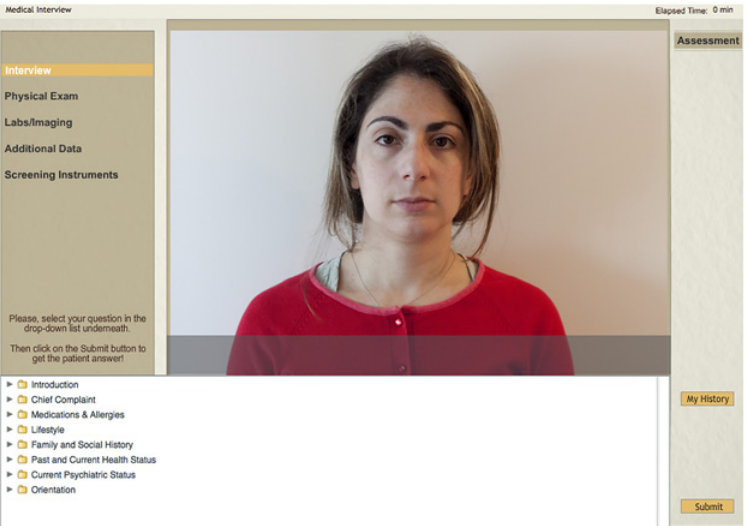
Fig 1. Screenshot of the Virtual Patient system illustrating the history-taking interview. The user can interact with the patient by choosing relevant questions divided in searchable appropriate categories and sub-categories. For illustrative purposes only, used with written permission by the portrayed